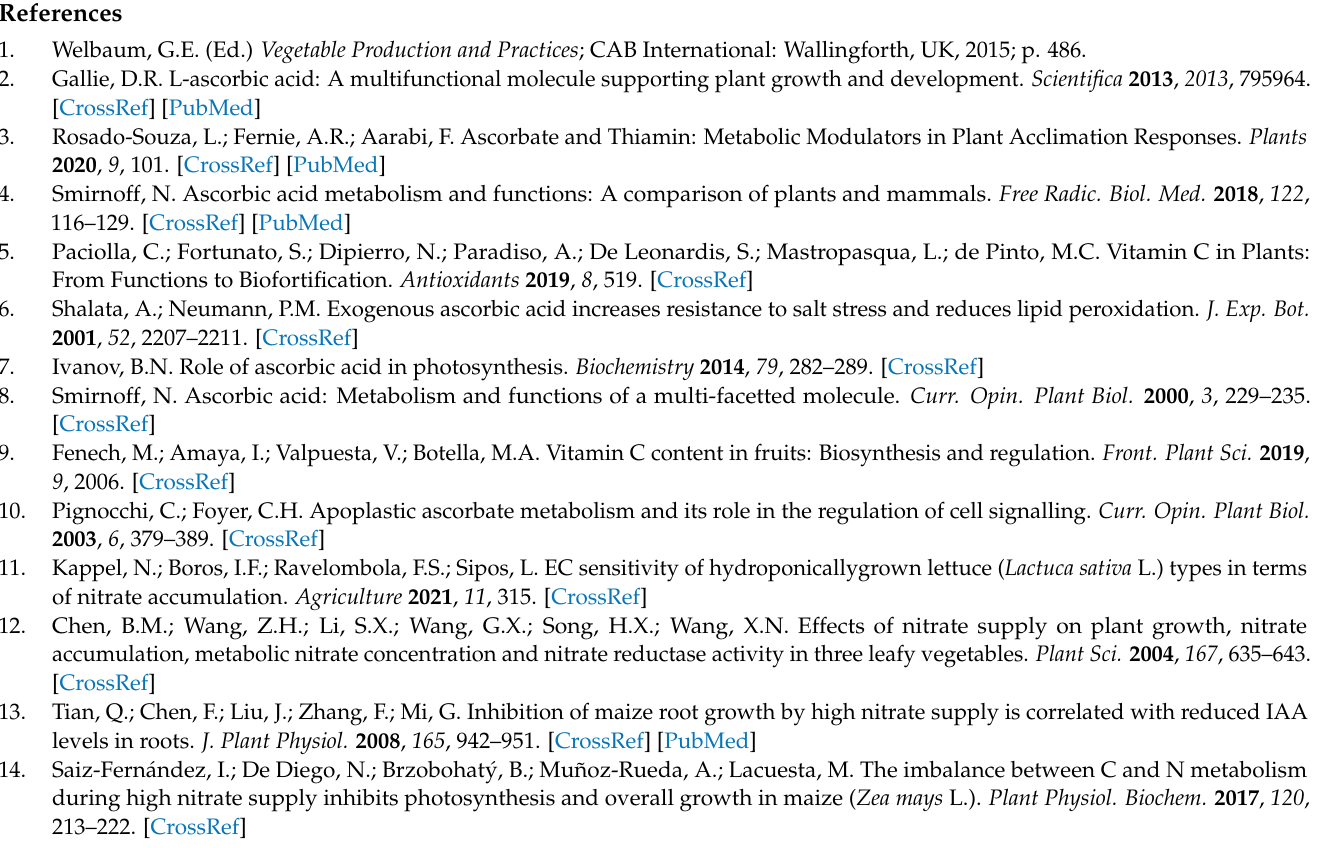
Table S2: Target genes, oligonucleotide primers and expected product sizes in RT-PCRs